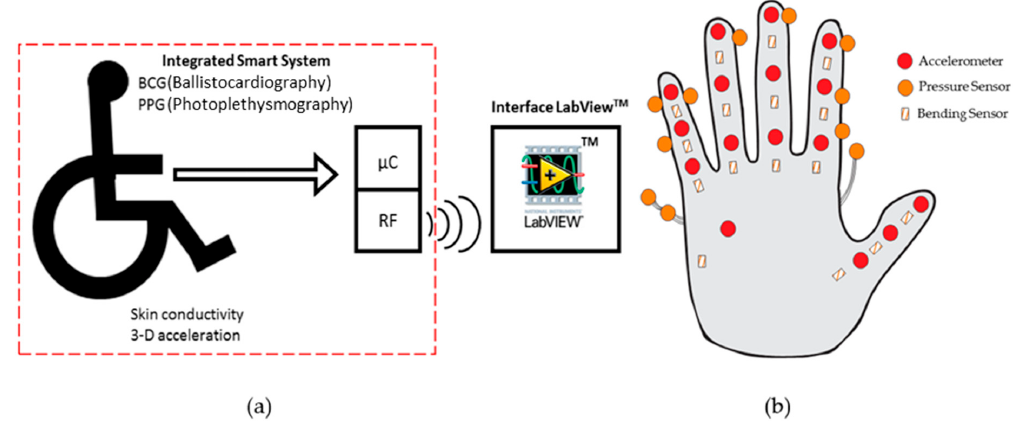
Figure 11. ( a ) Monitoring of vital signals via wheelchair and ( b ) Instrumented glove for assessments of rheumatoid arthritis